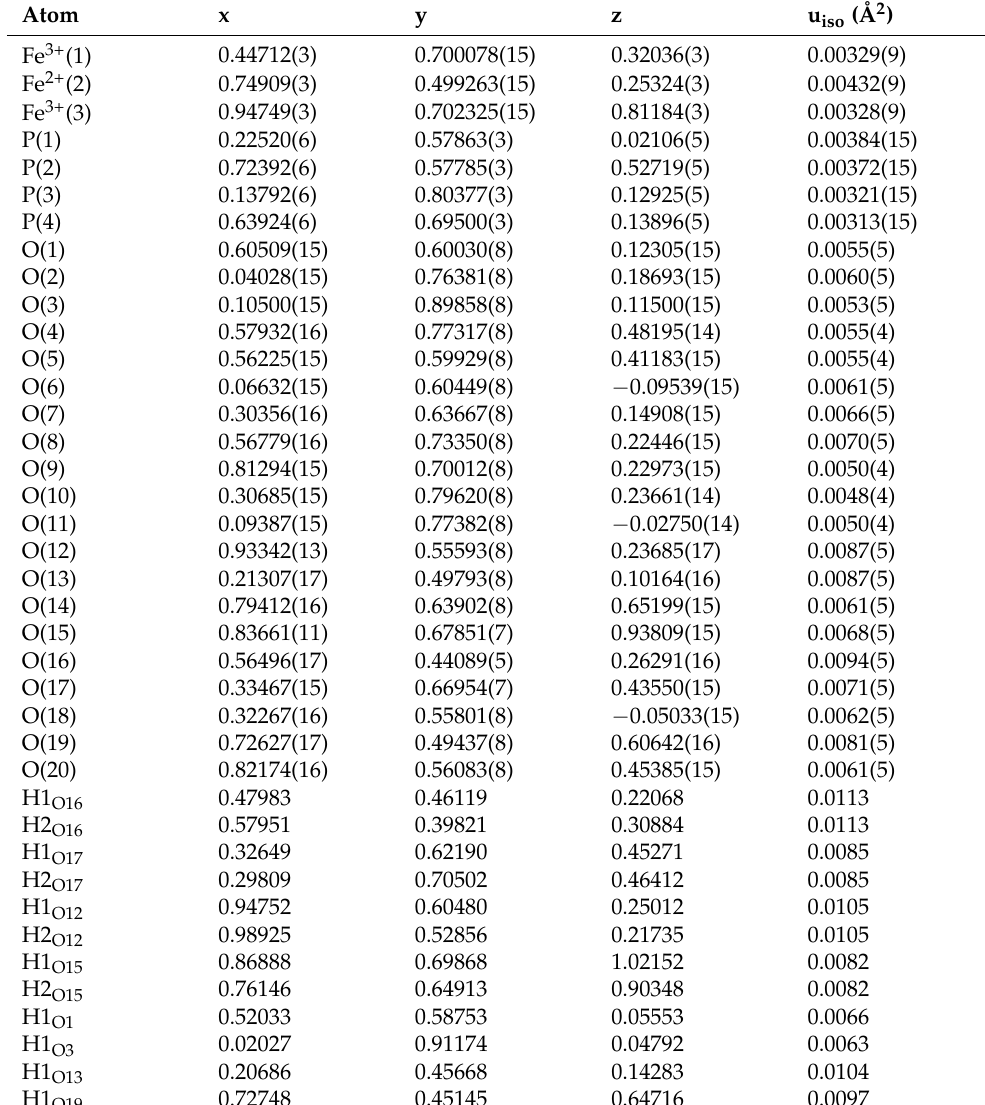
Table 3. Fractional coordinates at 100 K from laboratory X-rays. H atoms were constrained using a riding model with u iso extended by a factor 1.2 of its neighboring non-H